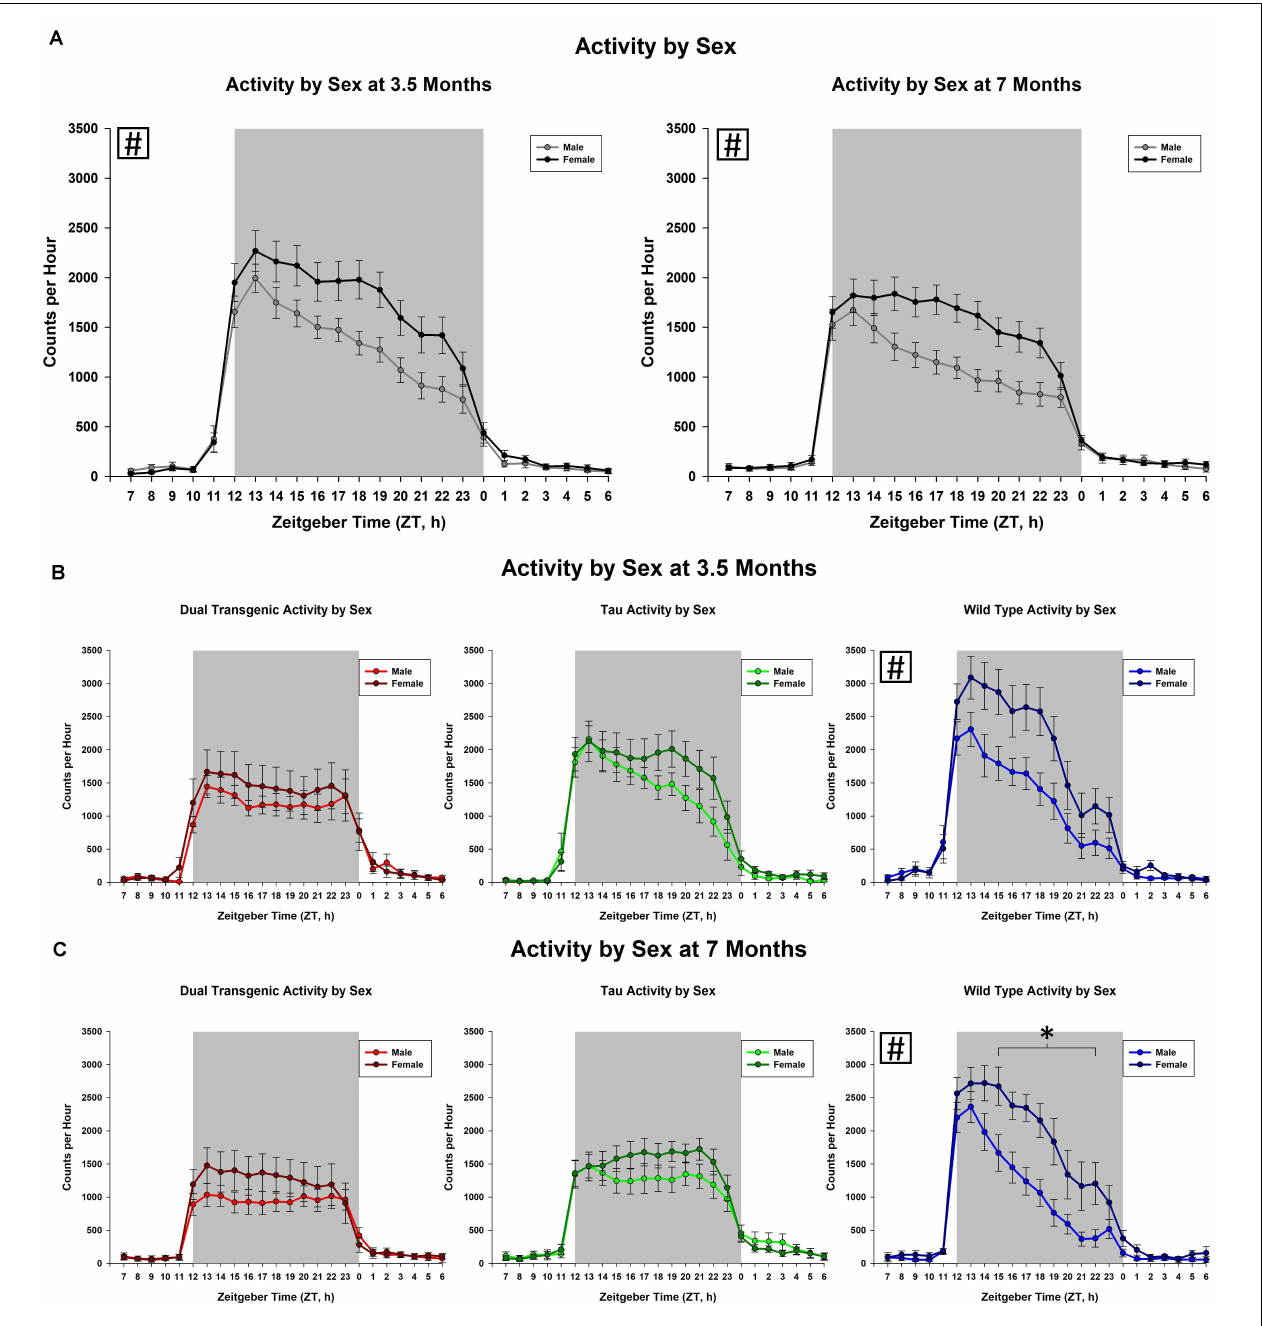
FIGURE 3 | Comparison of dark cycle activity by (A) sex by age, (B) sex by genotype at 3.5 months, and (C) sex by genotype at 7 months. Female animals showed significantly higher dark cycle activity compared to males at both 3.5 and 7 months (A) . At 7 months, this increase was present in hours ZT 15-22 (all time intervals, p < 0.05). Female wild type animals were significantly more active than wild type males at both 3.5 and 7 months ( ∗ p < 0.05, boxed # indicates a significant effect summed across dark cycle